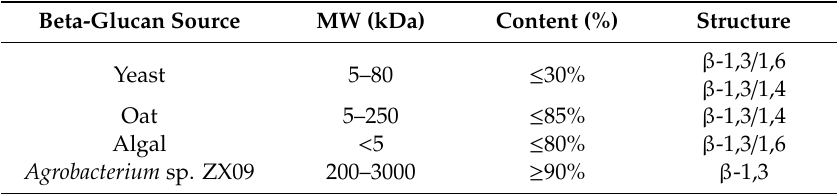
Table 1. Structure and content of beta-glucan